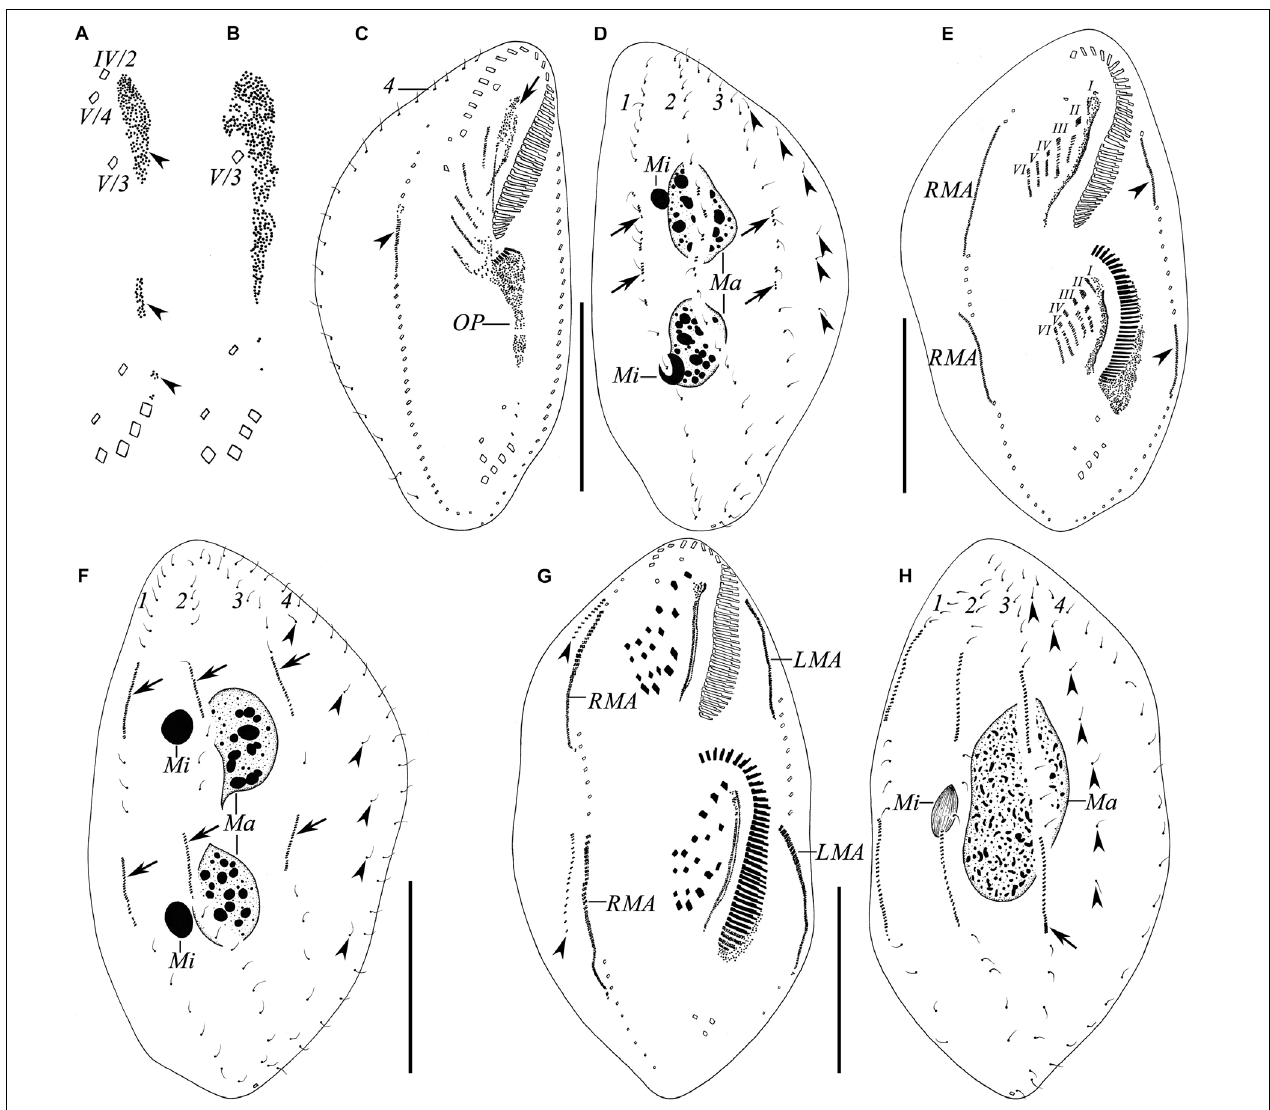
FIGURE 5 | (A–H) Ciliature of the Wuhan population of Rubrioxytricha haematoplasma during the ontogenetic process after protargol impregnation. (A,B) Ventral views of very early dividers, showing the formation of the oral primordium. (C,D) Ventral (C) and dorsal (D) views of an early divider, showing the formation of frontal–ventral–transverse cirral anlagen; arrow in (C) indicates undulating membranes anlage of proter (= anlage I) dedifferentiated from old structure; arrowhead in (C) marks right marginal anlage of proter; arrows in (D) show newly formed dorsal kinety anlagen; arrowheads in (D) indicate grandparental dorsal bristles. (E,F) Ventral (E) and dorsal (F) views of a middle divider, showing two sets of frontal–ventral–transverse cirral anlagen and dorsal kinety anlagen (arrows); arrowheads in (E) indicate left marginal anlagen of proter and opisthe; arrowheads in (F) indicate grandparental dorsal bristles. (G,H) Ventral (G) and dorsal (H) views of a late divider, showing newly formed frontal–ventral–transverse cirri, fused macronuclear mass and micronucleus; arrowheads in (G) mark dorsomarginal kinety anlagen formed near the anterior ends of right marginal anlagen; arrowheads in (H) indicate grandparental dorsal bristles; arrow marks new caudal cirrus formed at the end of dorsal kinety 3. LMA, left marginal anlagen; Ma, macronuclear nodules; Mi, micronuclei; OP, oral primordium; RMA, right marginal anlagen; I–VI, frontal–ventral–transverse cirral anlagen; 1–4, parental dorsal kineties. Scale bars = 50 µ